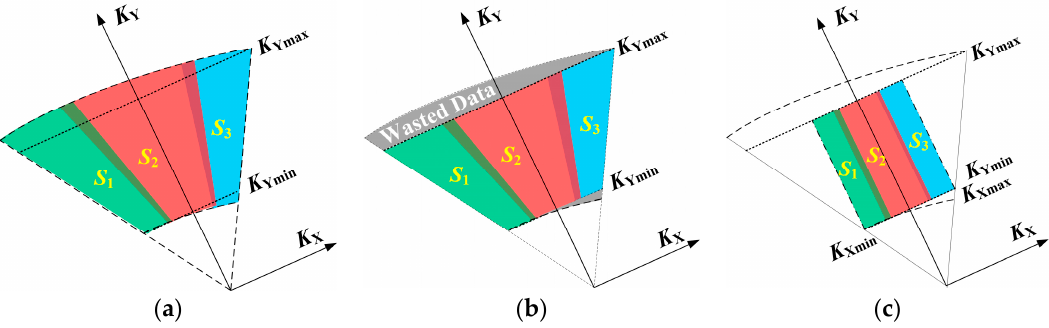
Figure 6. Wavenumber data distributed in: ( a ) polar format; ( b ) keystone format; and ( c ) rectangular format when employing the new parameter adjusting manipulation.